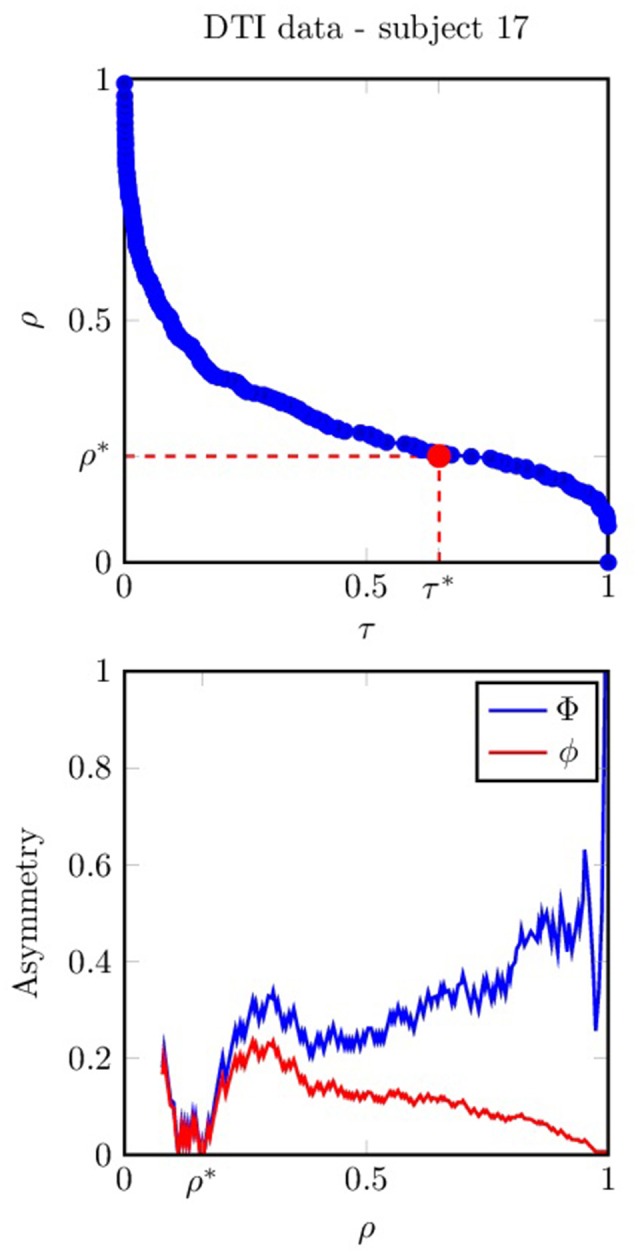
(Top) Network density ρ as a function of the connectivity threshold τ (plotted for one subject in our DTI dataset). (Bottom) Network asymmetry (red) and normalized network asymmetry (blue) as functions of the network density ρ. The optimal density ρ* is the largest value that minimizes the normalized network asymmetry.